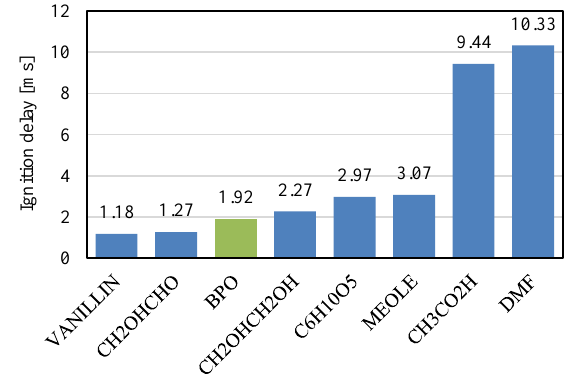
Fig. 21. Ignition delays all compounds of BPO